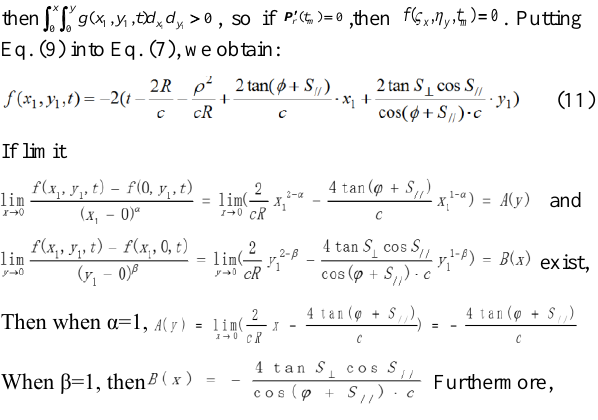
Figure 3. Peak position error distribution when the slope model is 16°.